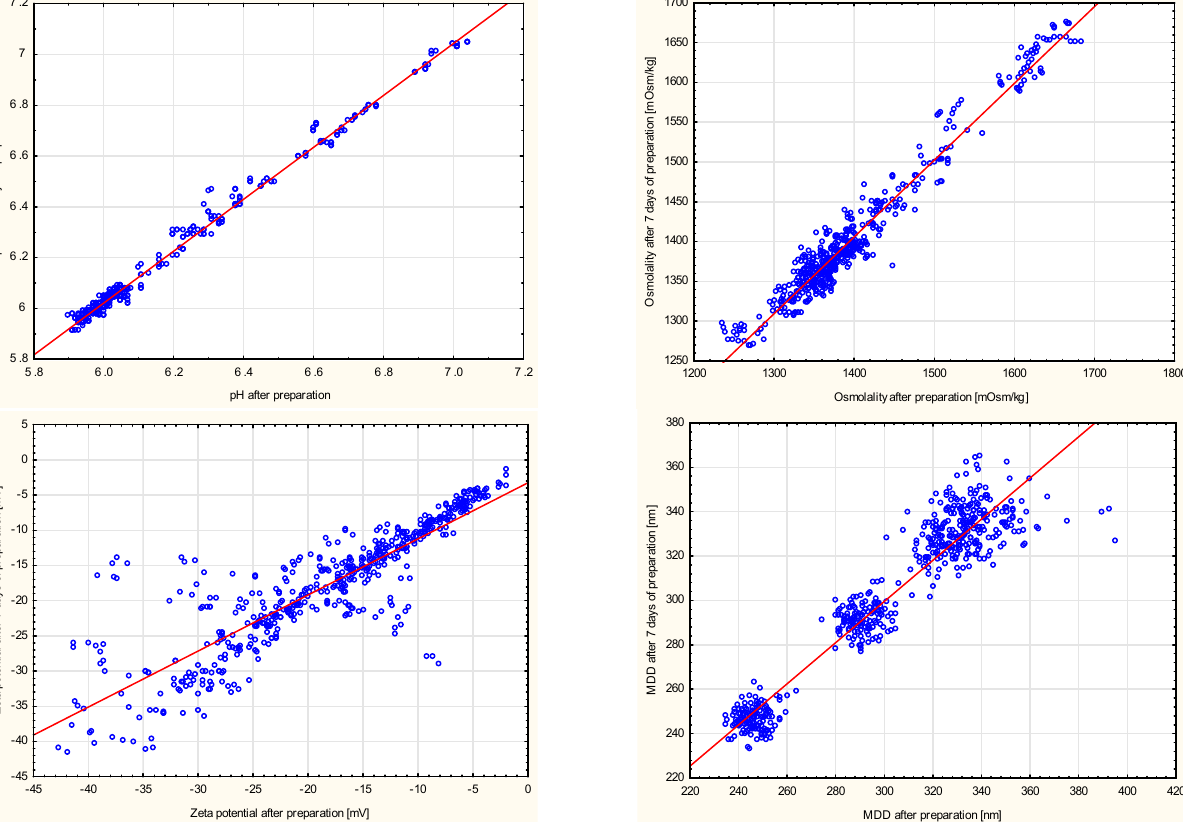
Figure 3. Correlation of pH, osmolality, zeta potential, and MDD immediately preparation and after seven days of storage.